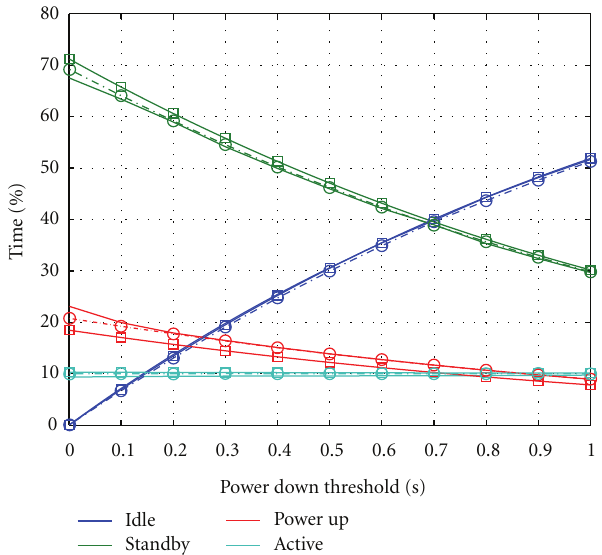
Figure 8: Energy estimates for P ow e r Up De lay = 0 . 001 seconds.